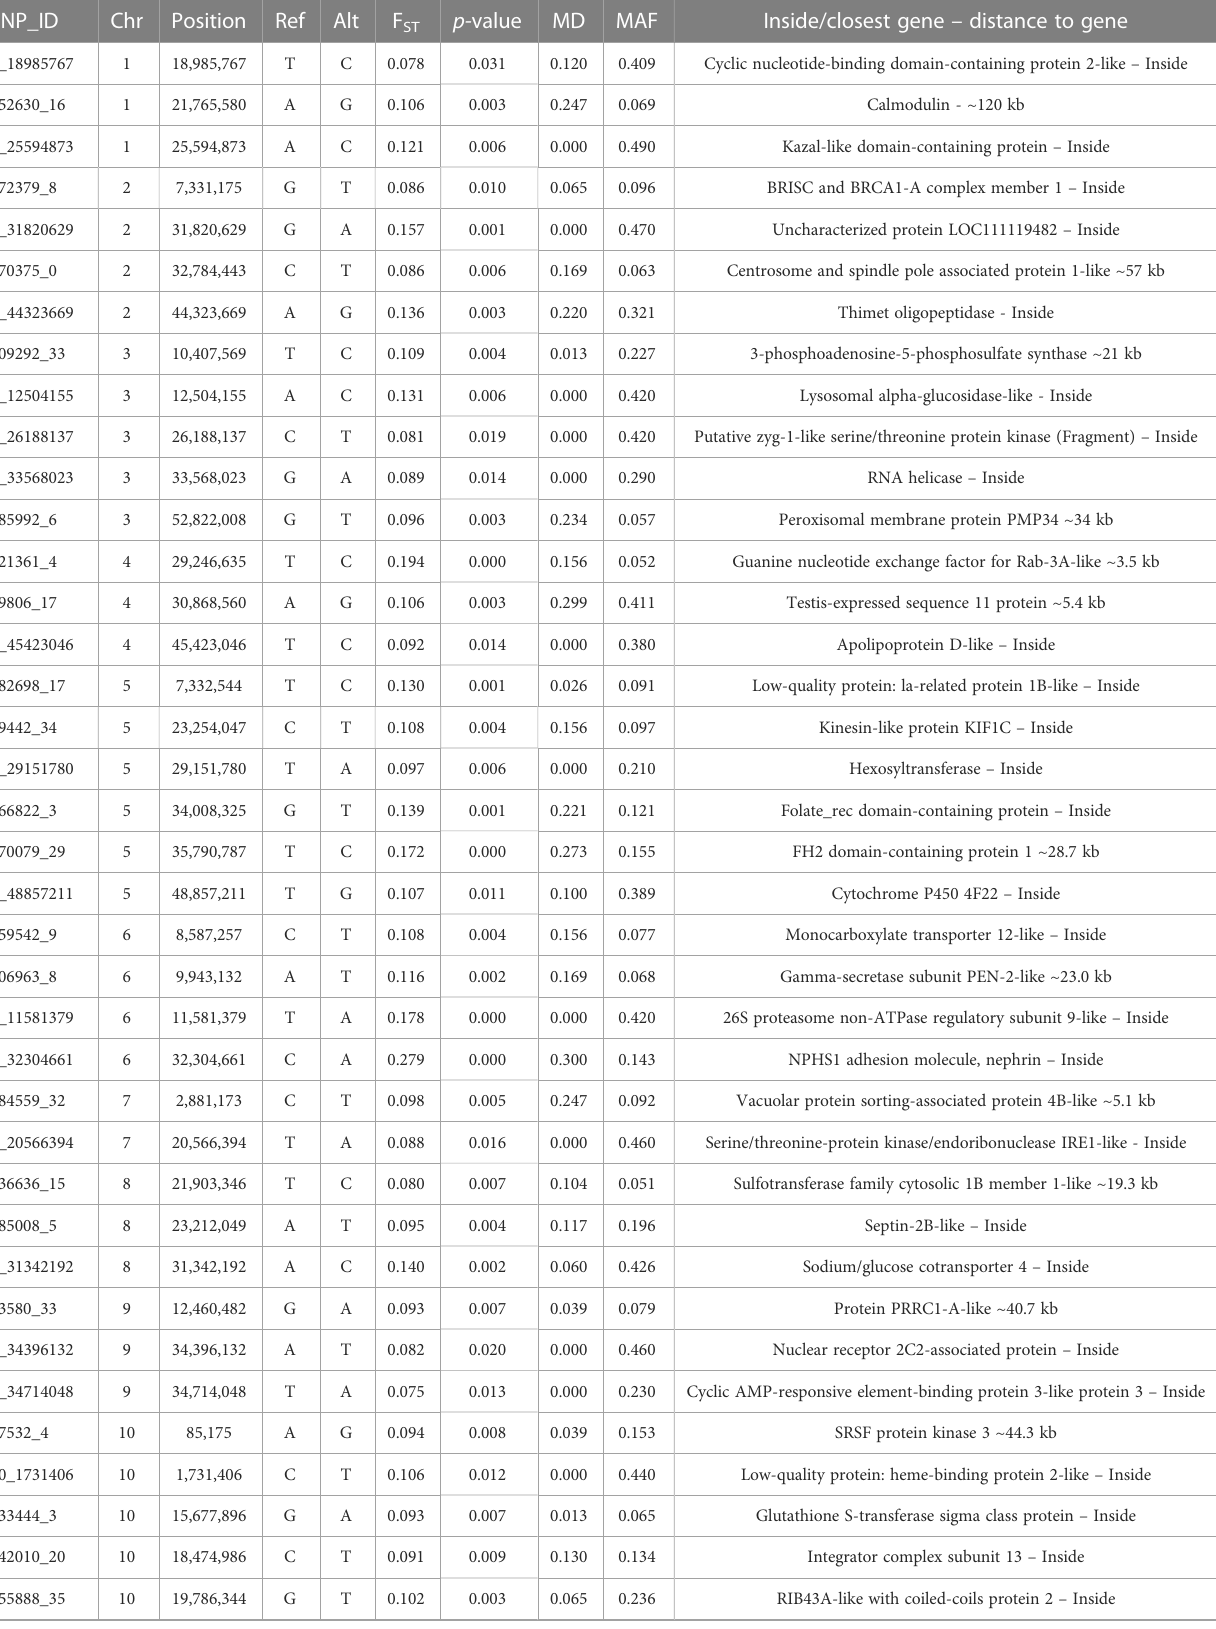
TABLE 6 List of the 60 SNPs selected from transcriptomic (TCAND) and population genomics (PGCAND) approaches positioned in the cockle Cerastoderma edule genome selected for resilience to Marteilia cochillia